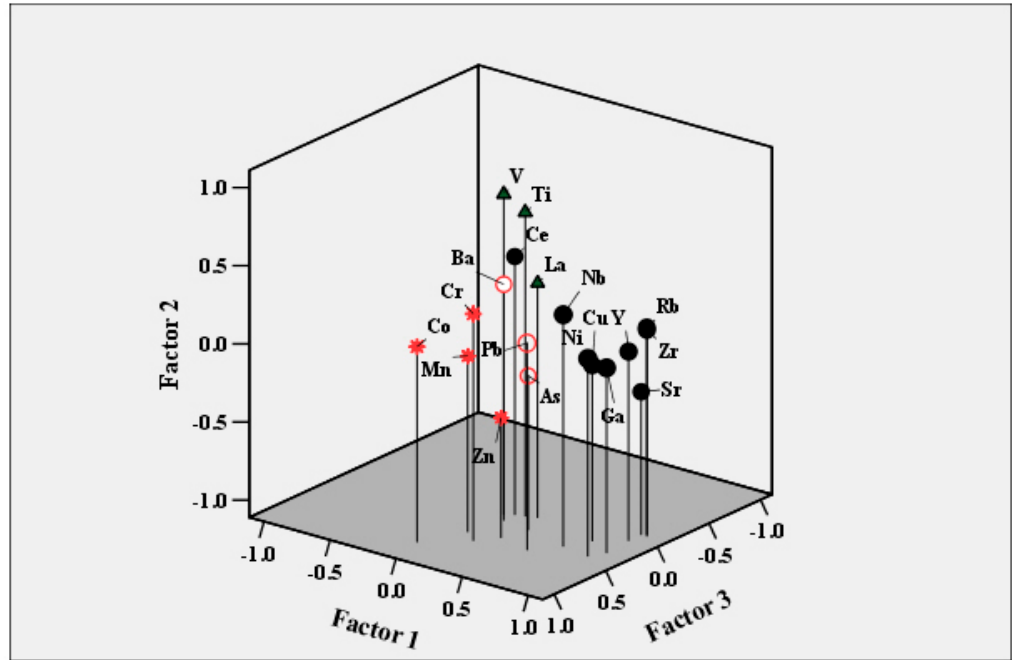
Figure 4. Loadings of the rotated eigenvectors obtained in a principal component analysis (PCA, Varimax rotation method) of the trace metals in SD in Xi’an, NW China.